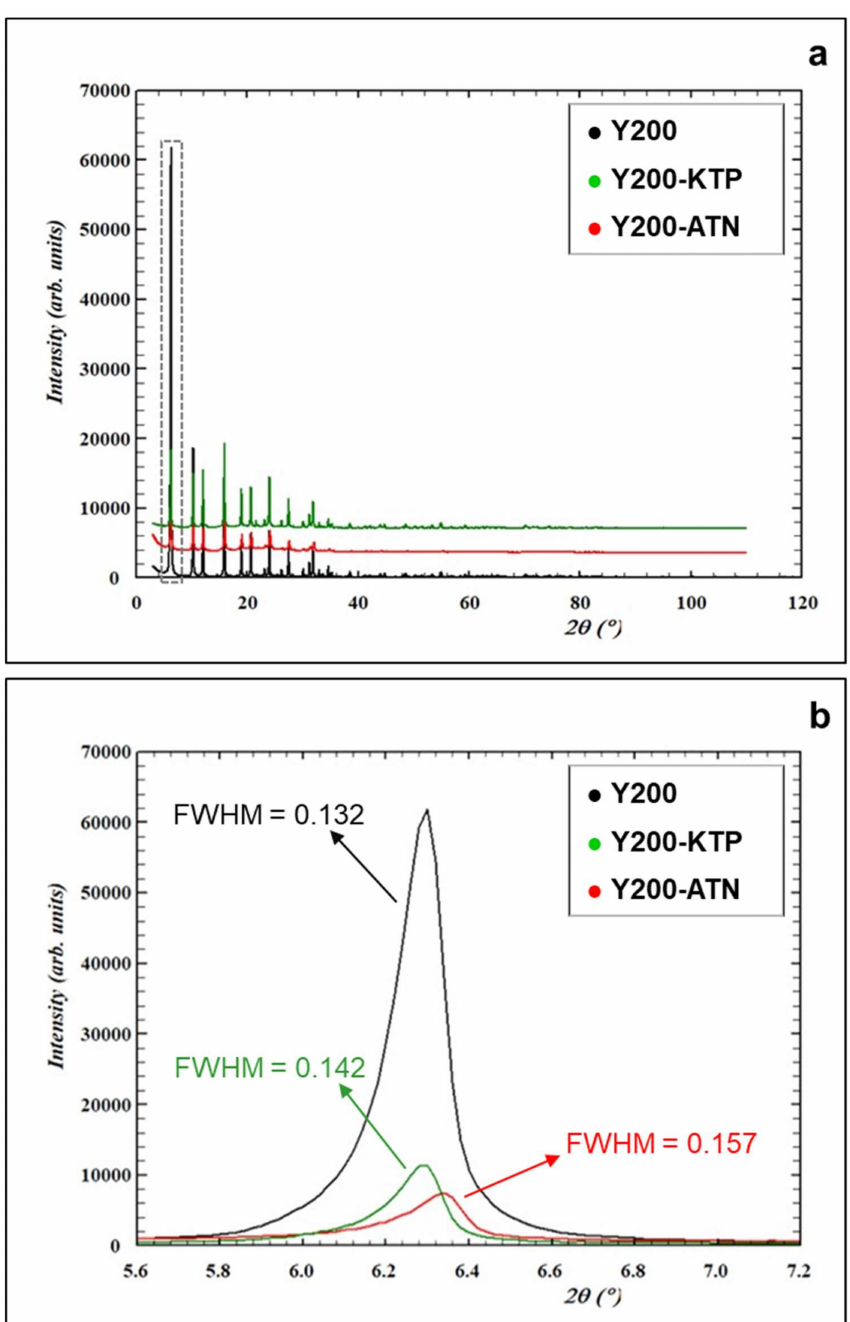
Figure 3. X-ray powders di ff raction pattern in the entire 2 ϑ range investigated ( a ) and in the low 2 ϑ region ( b ) of as-synthesized Y200 (black), Y200 saturated with KTP (green), and ATN